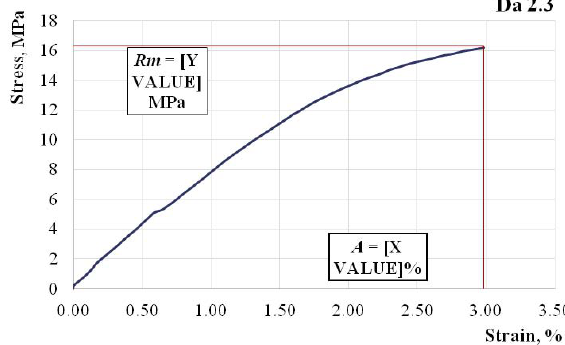
Figure 5. The characteristic curve of a Da 2.x representative